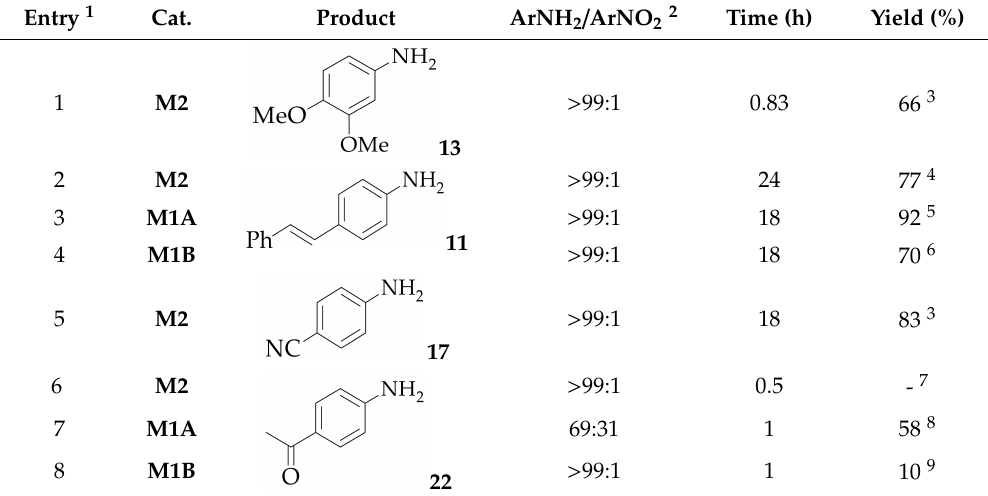
Table 9. Reduction of nitroarenes with sodium borohydride under catalysis by Rh